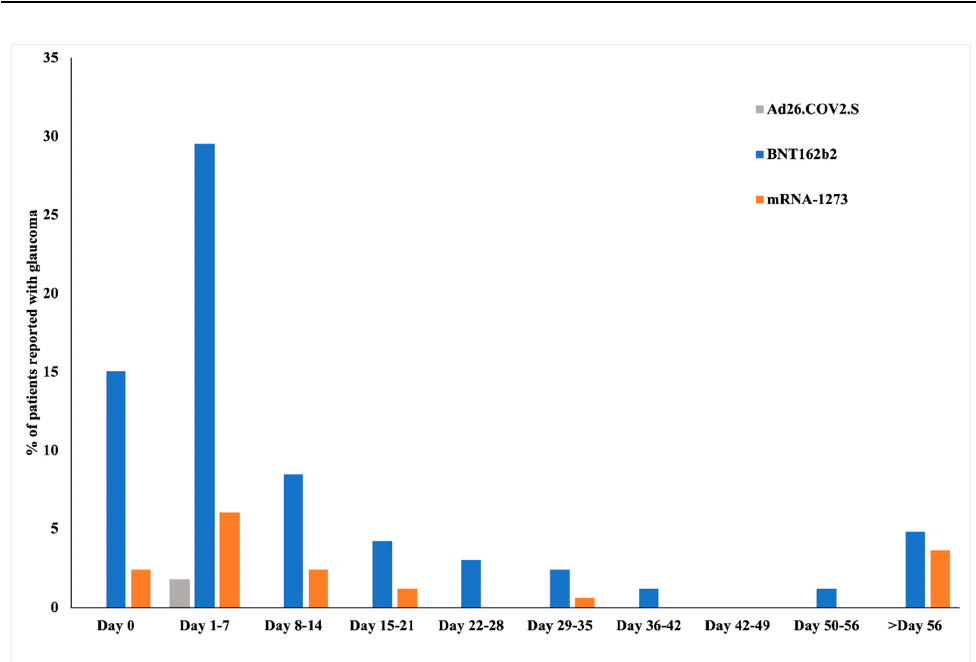
four patients (2.5%) received the rAd26.COV2.S vaccine (Table 2). Most of the cases ( n = day of vaccination (Figure 1).